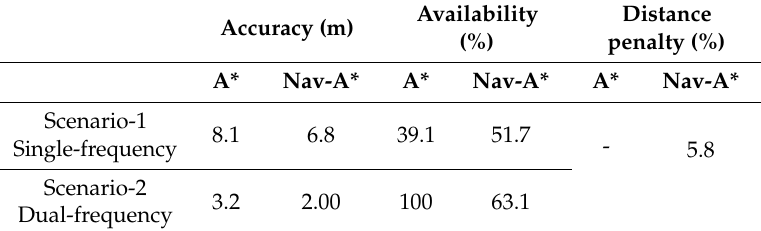
Table 1. Summary of simulation results.